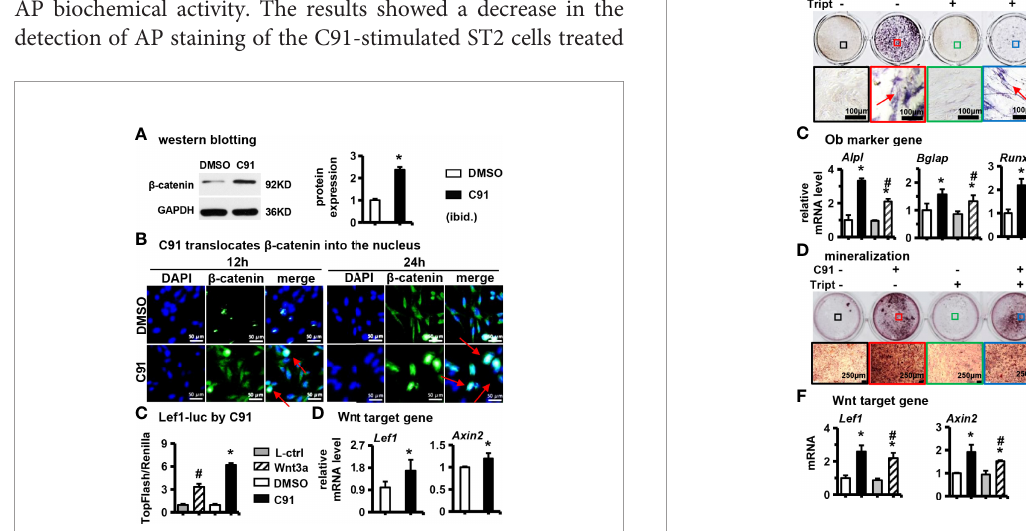
FIGURE 2 | Effects of C91 on Wnt/ b -catenin signaling pathway in ST2 cells. (A) ST2 cells were treated with C91 for 12 and 24 hours, and the samples were collected for immuno fl uorescence staining analysis of b -catenin. The red arrows indicate the protein of b -catenin into the nucleus. Scale bar = 50 m m. (B) Western blot detection of protein b -catenin expression. (C) TopFlash is a reporter gene plasmid used to detect the level of b -catenin-mediated TCF/ LEF transcriptional activity in Wnt signaling pathway, and FopFlash plasmid is its negative control. ST2 cells were transfected with TopFlash and FopFlash plasmids and then treated with C91, L-ctrl and Wnt3a conditioned medium for 3 days. Samples were collected and assayed for luciferase activity. (D) qRT-PCR detection of Wnt target gene expression. Results are expressed as mean ± SD (n = 3 per group). * indicates P < 0.05, compared with the DMSO group. # indicates P < 0.05, compared with the C91 group.